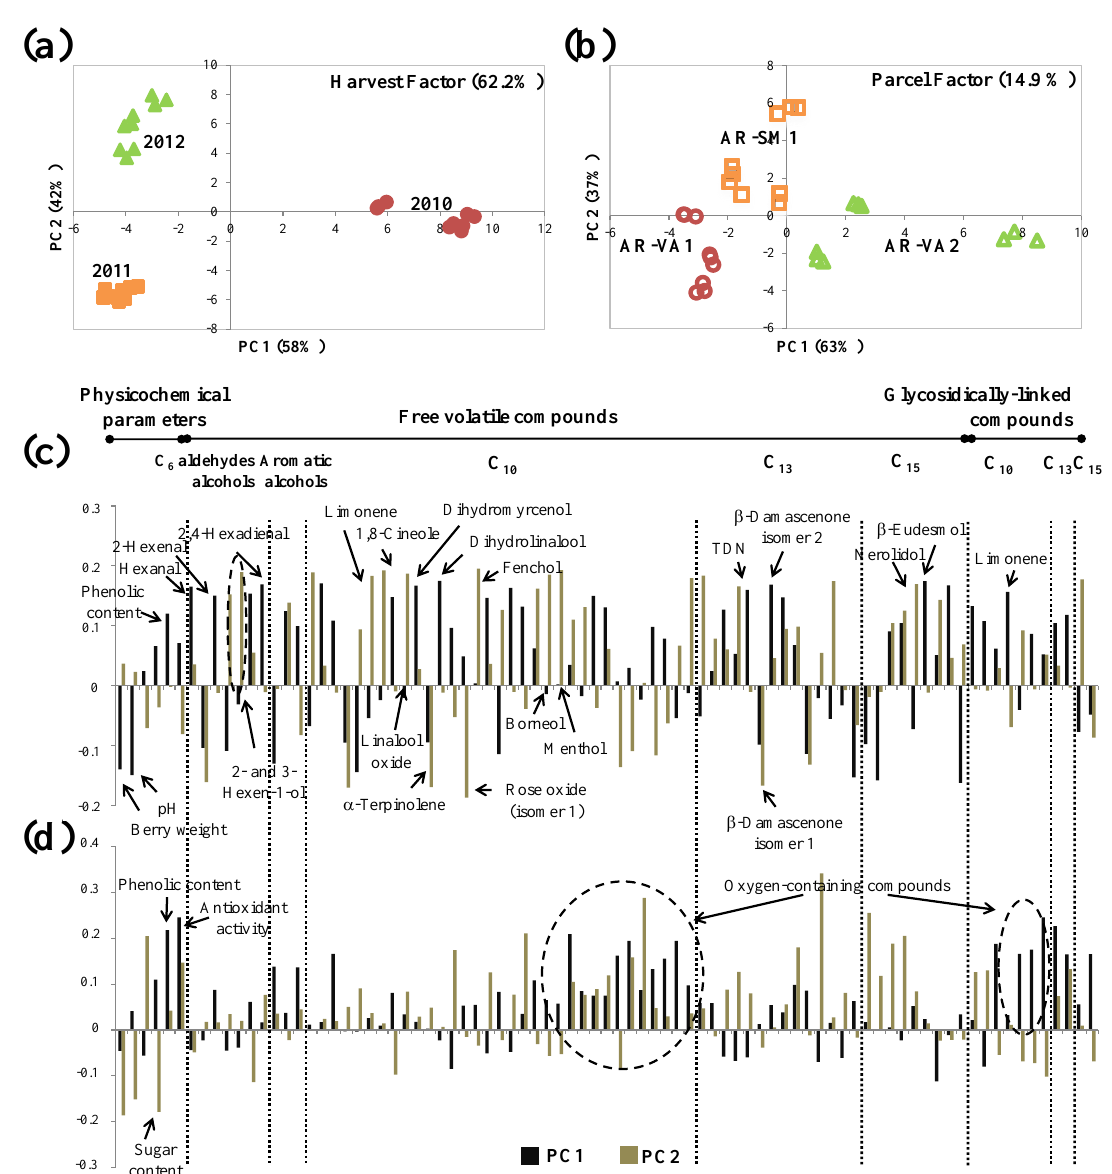
Figure 4. ASCA scores plot for ( a ) harvest and ( b ) parcel factors, and the corresponding variable loadings plot ( c , d ), respectively, obtained for Arinto, at technological maturity (significance test reported on Table 4). Each variable is normalized separately by dividing by its standard deviation value.